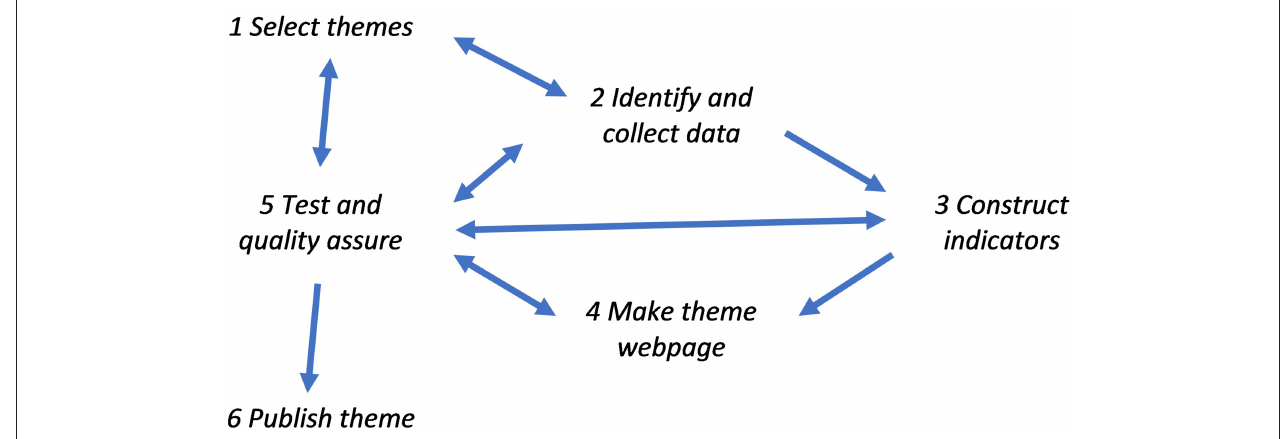
FIGURE 1 | Sketch of workflow in main project to select and design